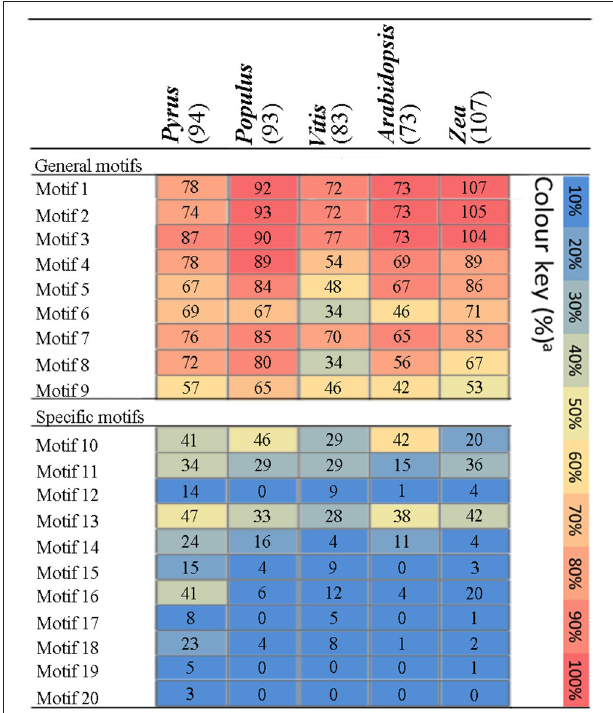
FIGURE 3 | Distribution of amino acid motifs in PRX proteins from Pyrus bretschneideri Rehd, Populus trichocarpa , A rab idopsis thaliana , Vitis vinifera, and Zea mays . Colure key: The percentage of PRX sequences in each genome containing a particular motif was represented by a heat map.